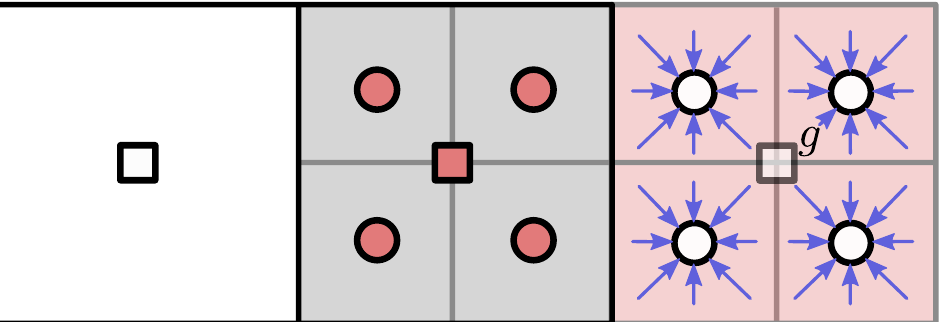
Figure 7. Grid transition interface for two-dimensional cell-centered layout including coarse ghost g nodes needed for central-difference approximation of velocity gradients during HRR collision at coarse interface nodes , light-red area indicates coarse ghost cell from which fine pre-collision populations, represented as arrows, are gathered and averaged during fictitious coalescence according to Equation